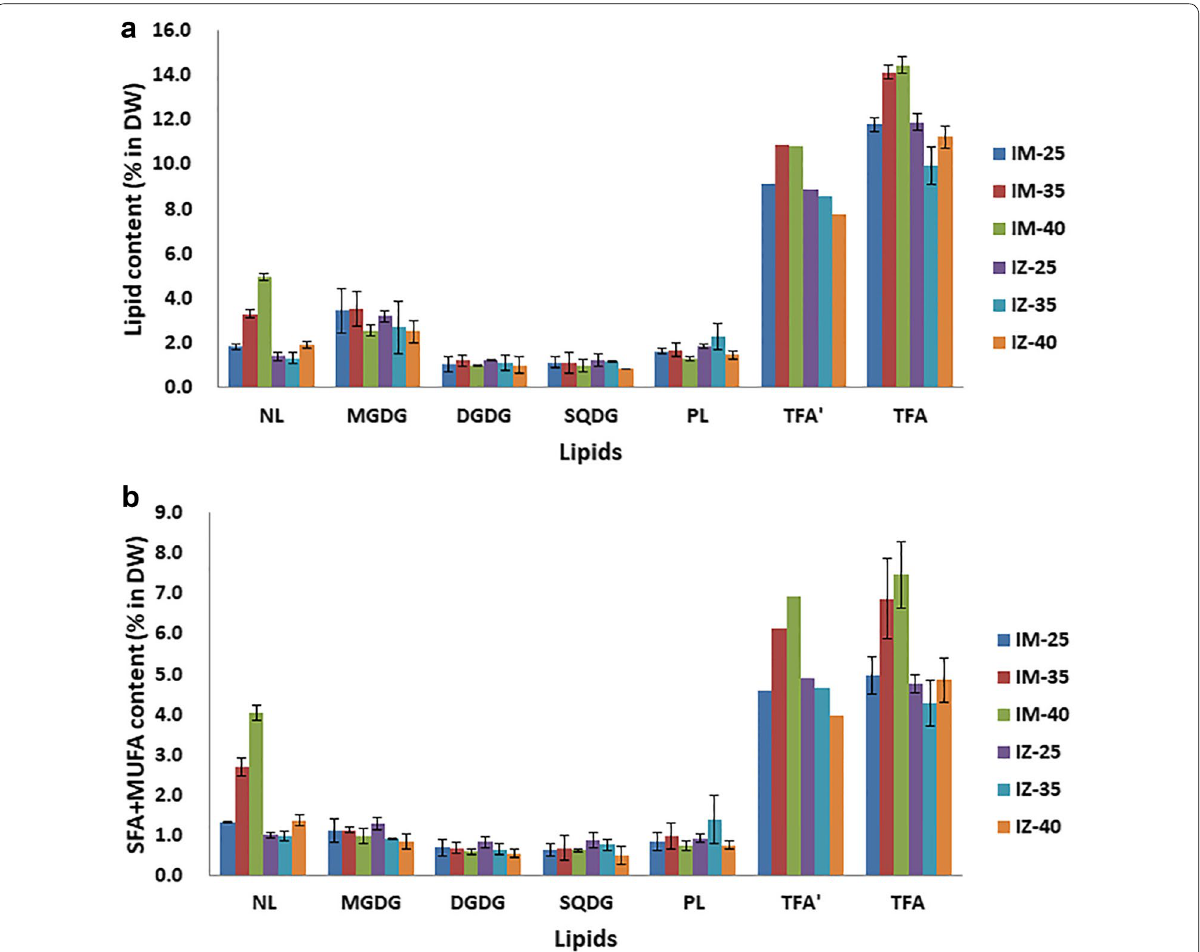
Fig. 5 The content of total fatty acids (% DW) of WT and IM at 25, 35 and 40 °C. a Lipid content (% DW). b Saturated and monounsaturated fatty acids (% DW) of NL, GL and PL. TFA ′